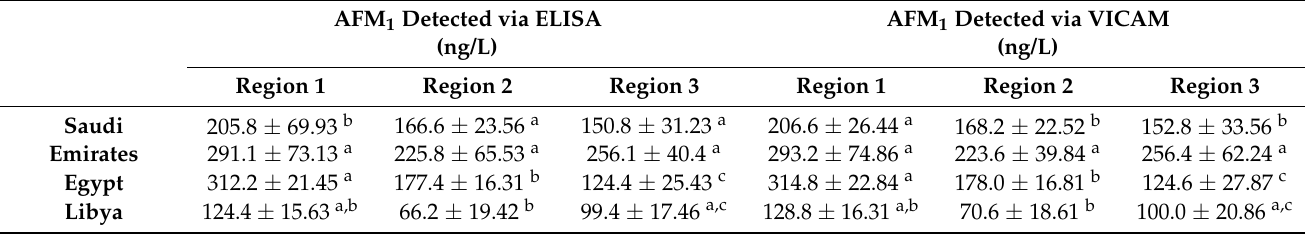
Table 1. Determination of aflatoxin M 1 in camel milk collected from two regions, the Arabian Peninsula and North Africa, evaluated using ELISA and VICAM